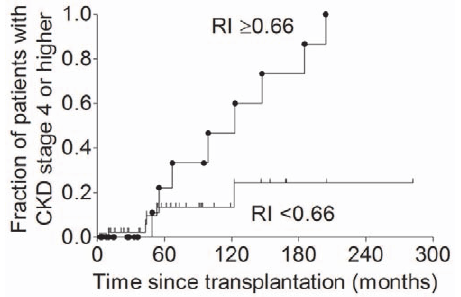
Figure 1. Kaplan-Meier estimates of the fraction of patients presenting with chronic kidney disease stage 4 or higher according to renal arterial resistive index. Patients were stratified according to renal arterial resistive index (RI) below or above the upper quartile, i.e. 0.66. Relative risk, 4.64; 95% confidence interval, 1.71 to 12.55; p=0.003.